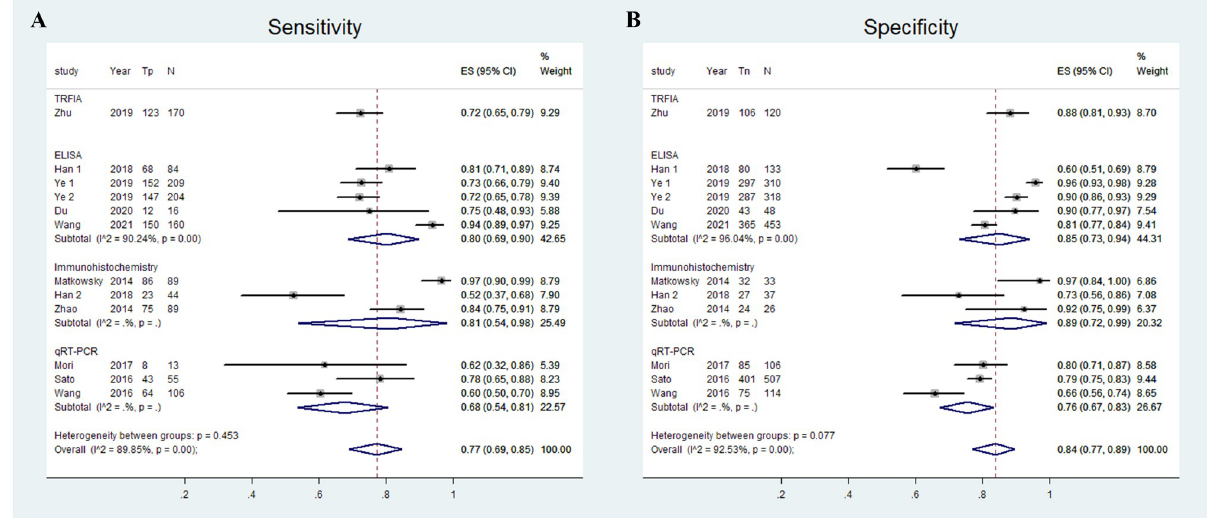
Fig 4. Pooled sensitivity and specificity of AKR1B10 levels measured by different detection methods for the diagnosis of HCC.